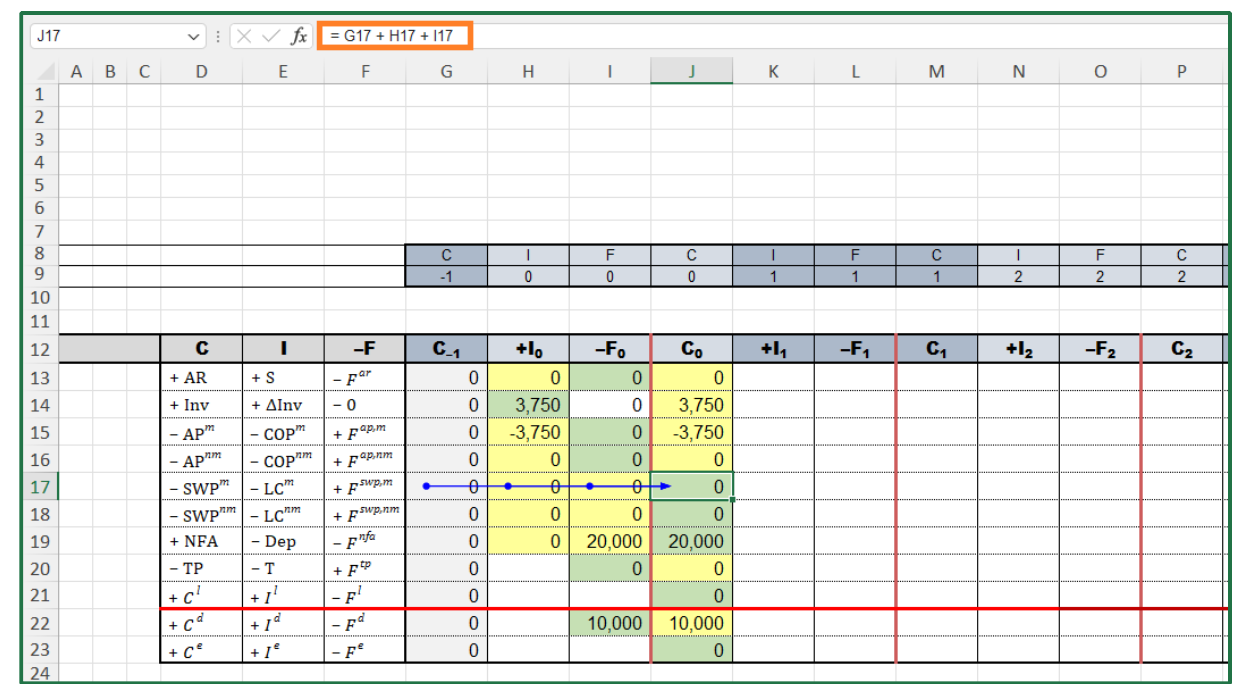
Figure 13. The cells whose values are calculated with the law of motion are in green. Cell J17 contains the law of motion for SWP m (“SplitScreenStrip” sheet). (The cells whose values are provided in “PreCalc” are in yellow and the cells whose values are calculated with the law of motion are in green.)